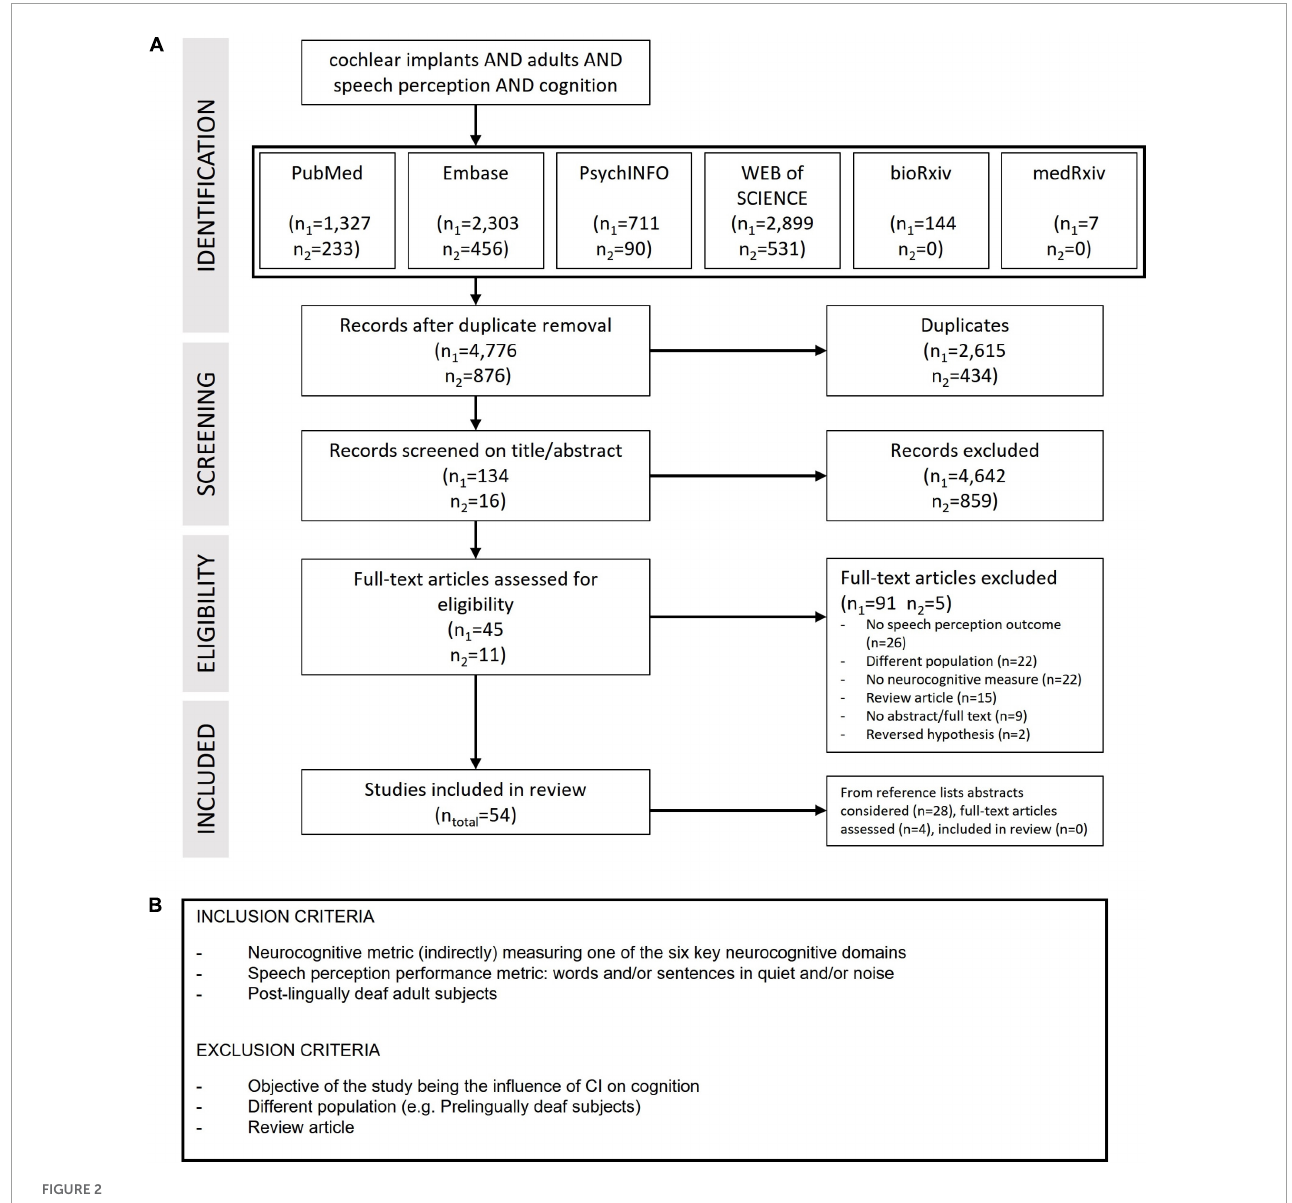
FIGURE2 (A) Preferred reporting items for systematic reviews and meta-analysis (PRISMA) flowchart of the literature search and study selection. Last date of first search June 2020, numbers are indicated with n 1 . Last date of second search April 2022, numbers are indicated with n 2 . (B) Inclusion and exclusion criteria of the